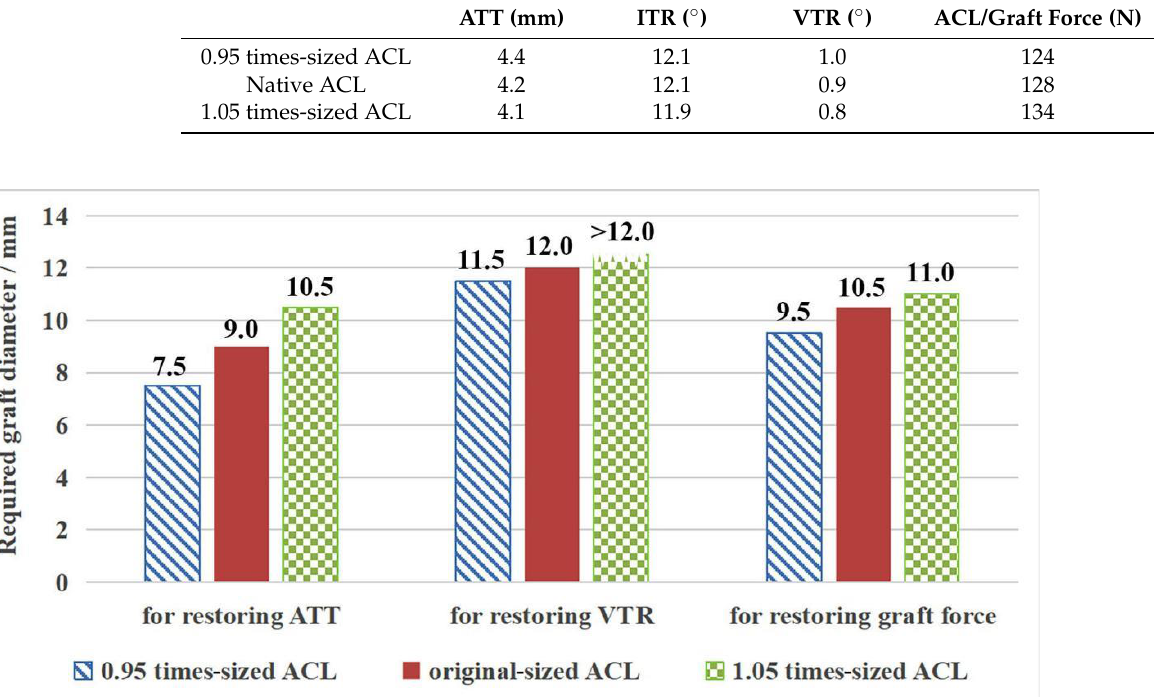
Table 3. Anterior tibial translation (ATT), internal tibial rotation (ITR), valgus tibial rotation (VTR) and ACL/graft force in the intact knee with different sized ACL.